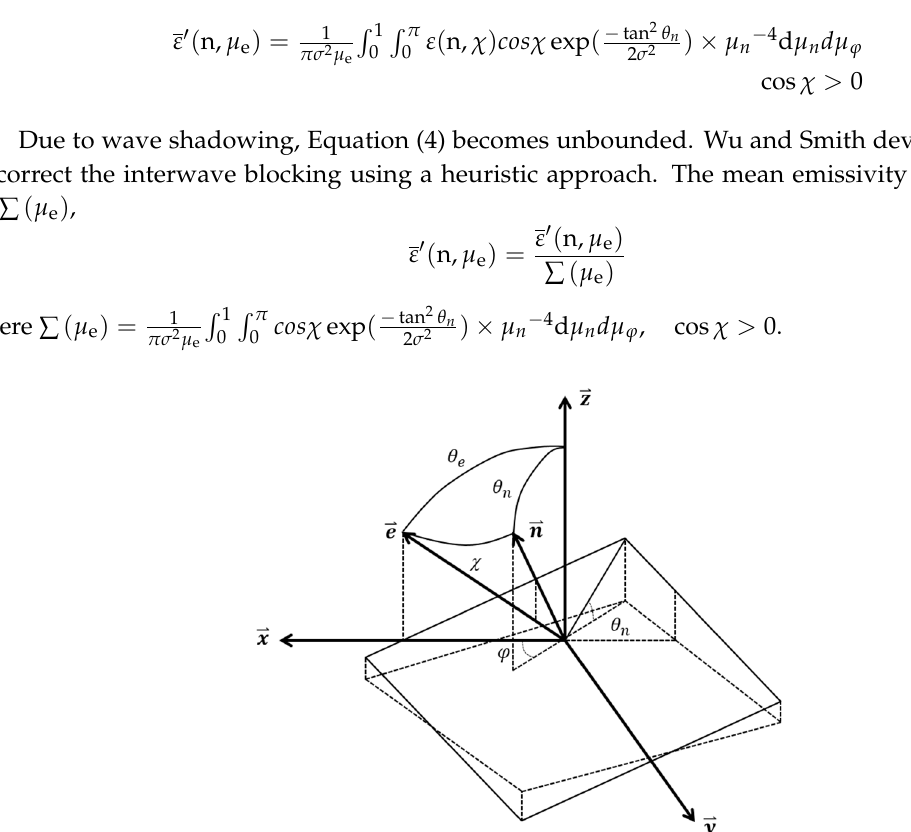
Figure 2. Geometry of emission from a wave facet tangent to the instantaneous sea surface, after Wu and Smith [16]. z is the local zenith; the other two orthogonal components of the Cartesian coordinate system, x and y, are defined such that e , the unit vector of the emission, is in the x-z plane. n is facet unit normal vector; θ n and ϕ are its zenith and azimuth angles, respectively; θ e and χ are zenith angles of emission e relative to the local zenith z and the facet norm n , respectively.